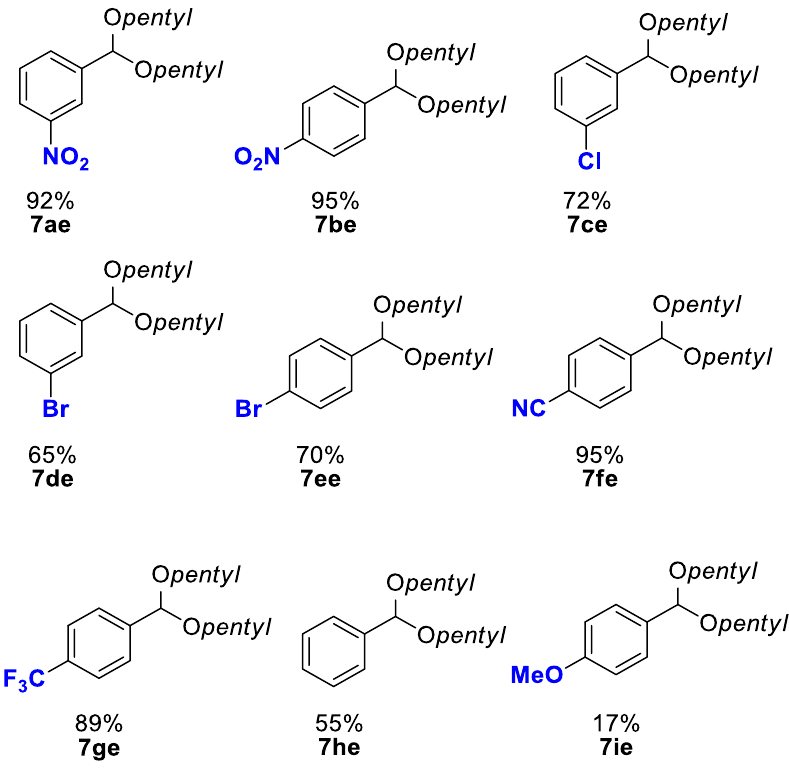
Figure 9. Scope of the reaction. Experimental conditions: a mixture of aldehydes (0.1 mmol) and catalyst (10 mol%) in 0.25 mL of n -amyl alcohol 6e was stirred at 60 °C. After 24 h, the reaction crudes were purified by column chromatography.